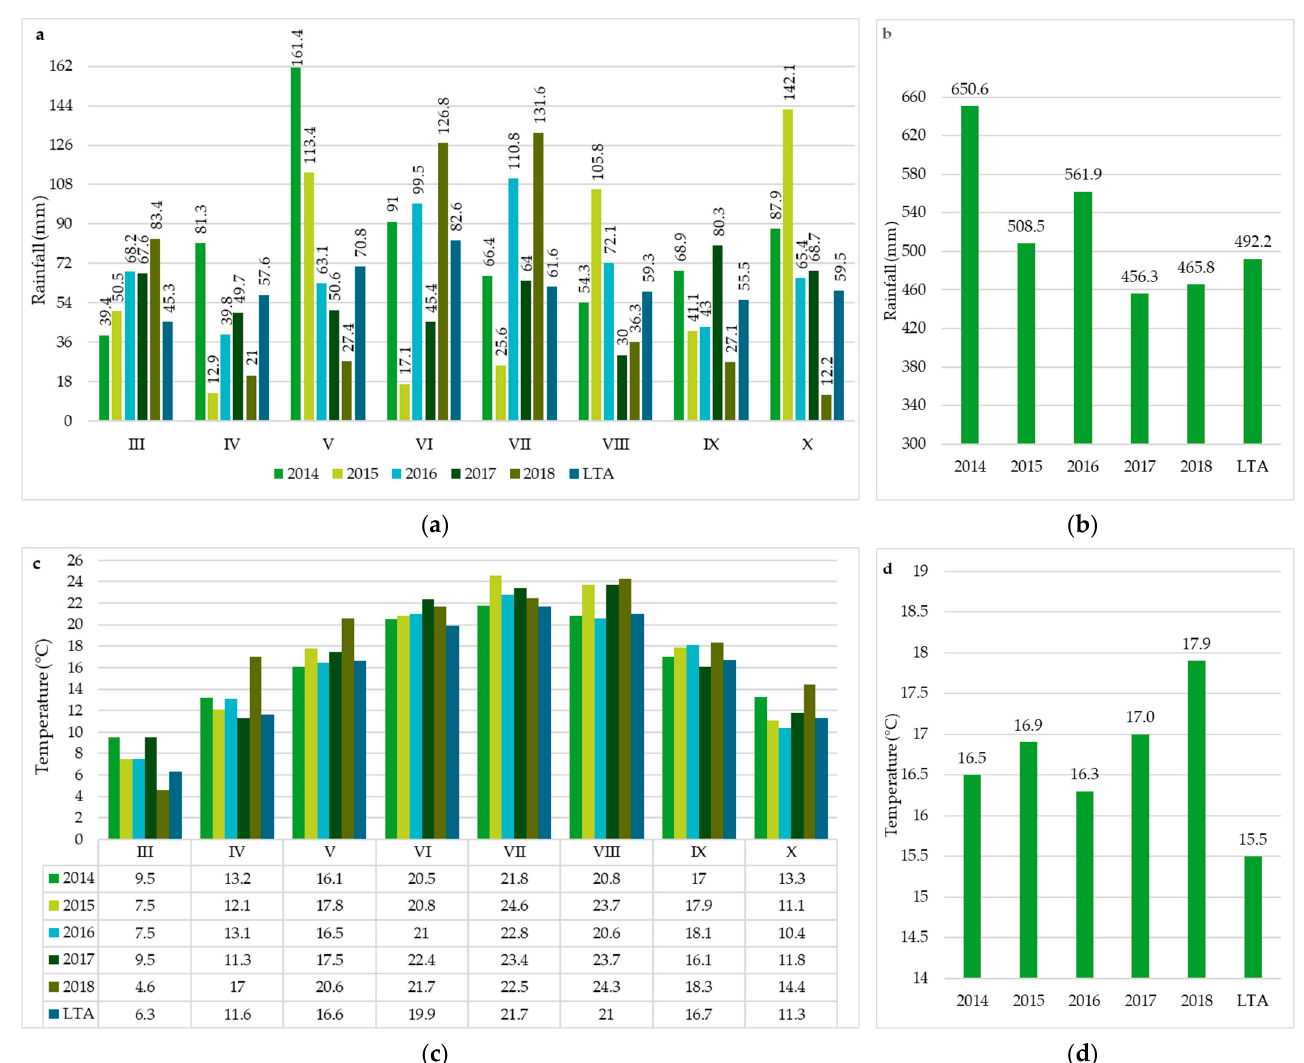
Figure 2. Meteorological data—( a ) total monthly rainfall; ( b ) total rainfall of the growing seasons; ( c ) mean monthly air temperatures; ( d ) mean air temperature of the growing seasons)—during the study period (2014–2018) and long-term average (1899–2020, LTA) at the experimental location Osijek, Croatia (Source: Croatian Meteorological and Hydrological Service, CMHS).